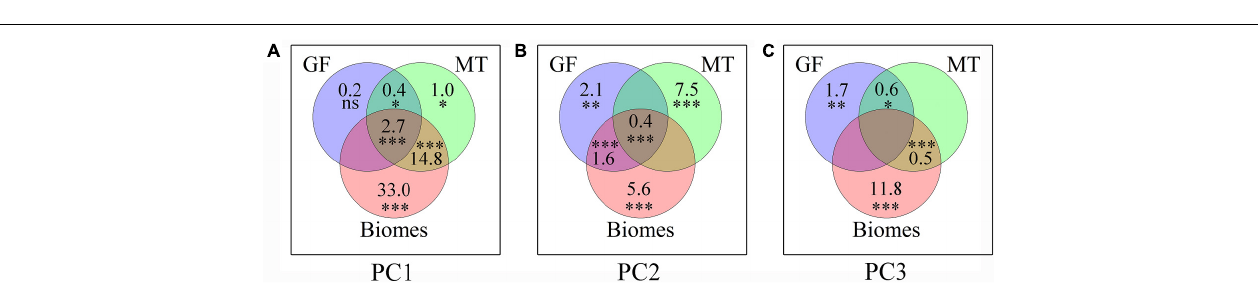
FIGURE 3 | Distribution of plant growth forms, mycorrhizal types, and biomes along the first three main principal components (i.e., PC1–PC3) of the root trait covariation. (A,D,G) Plant growth form (GF); (B,E,H) mycorrhizal type (MT); (C,F,I) biomes. Letters represent statistically significant differences in the average PCs (Tukey’s HSD post hoc test, P < 0.05), such that groups not containing the same letter are different. In the box plots the central line represents the mean; the lower and upper box limits correspond to the 25th and 75th percentiles and the upper (lower) whiskers extend to 1.5 (–1.5) times the interquartile range, respectively. AM, arbuscular mycorrhizal; ECM, ectomycorrhizal; ERM, ericoid mycorrhizal; NM, non-mycorrhizal.